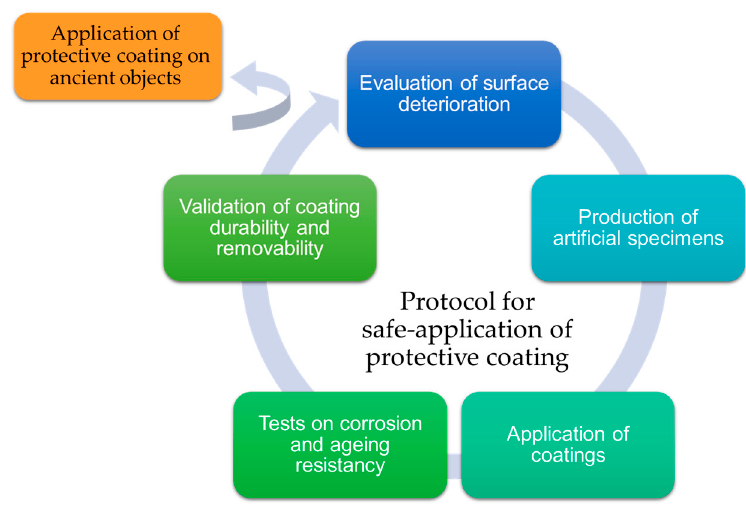
Figure 10. Protocol to design a safe application of new protective coating.